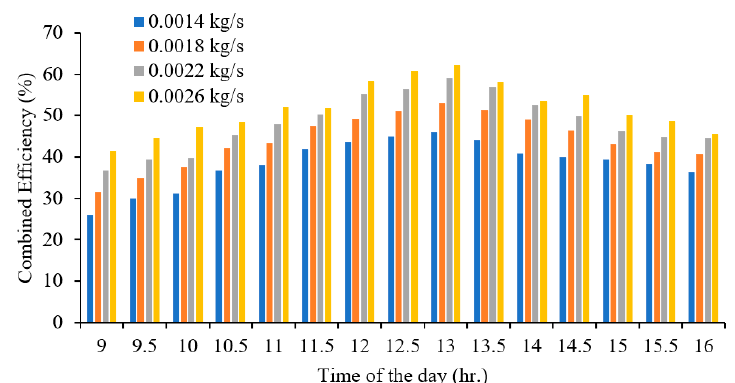
Figure 5. The efficiency of PV/T at different daytime. Figure 4. Outlet and inlet temperature difference at different time periods of the day ( a ) for air, ( b ) for water.